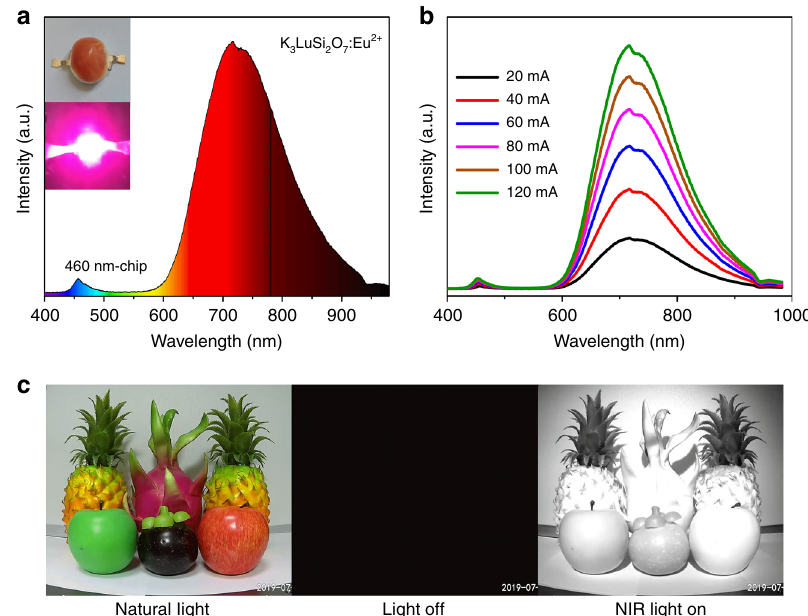
Fig. 4 NIR application of K 3 LuSi 2 O 7 :Eu based pc-LEDs. a Photographs and PL spectrum of as-fabricated pc-LED combining a commercial blue LED and K 3 LuSi 2 O 7 :0.01Eu 2 + phosphor. b PL spectra of the pc-LED upon various forward bias currents. c Photographs under natural light and NIR pc-LED light captured by the corresponding visible camera and a NIR